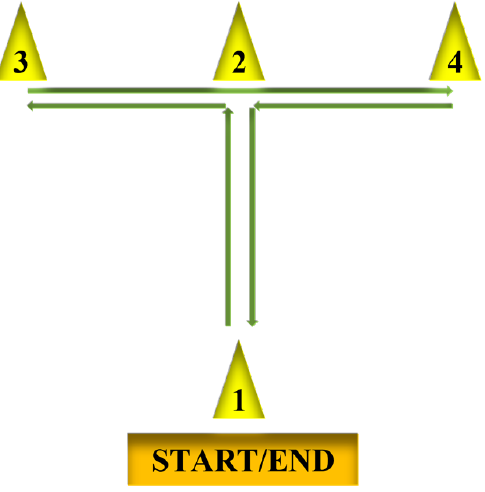
Figure 1. Agility T -test procedure.